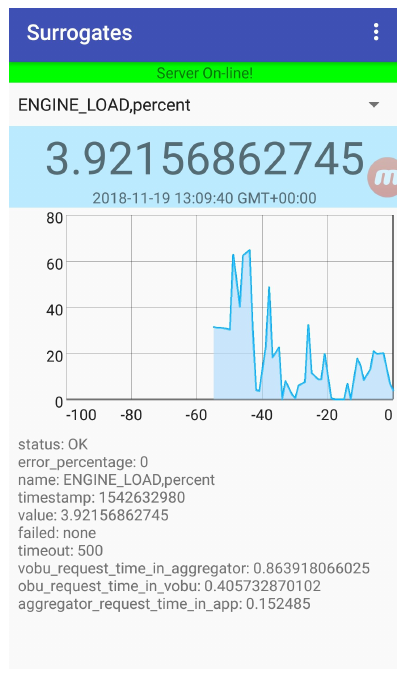
Figure 6. Screenshot of the Android app requesting vehicle